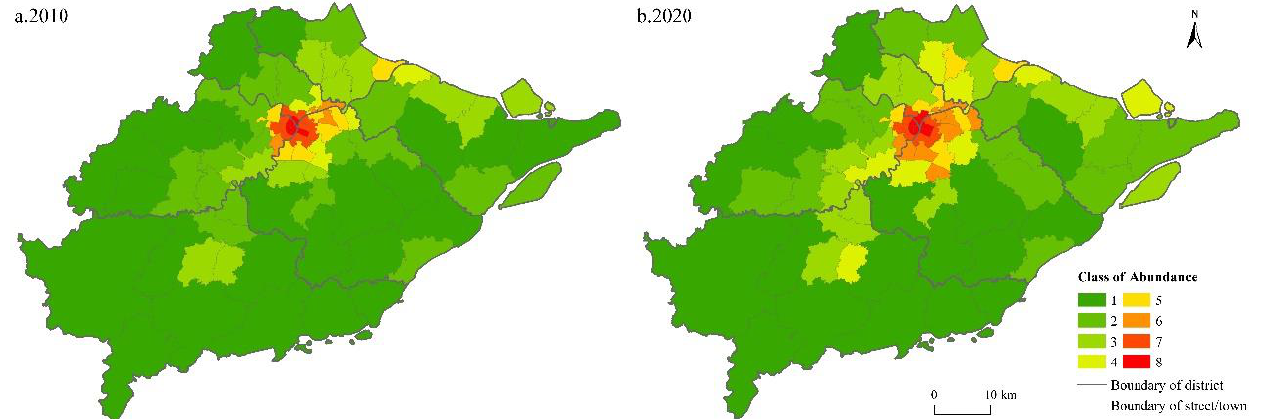
Figure 5. The abundance of cultural enterprises in the central district of Ningbo in ( a ) 2010 and ( b ) 2020. Note: This map is based on the standard map of the Map Technical Review Centre of the Ministry of Natural Resources of China (Number: Zhejiang S (2022)34), with no modifications to the base map. Map-making by the author.